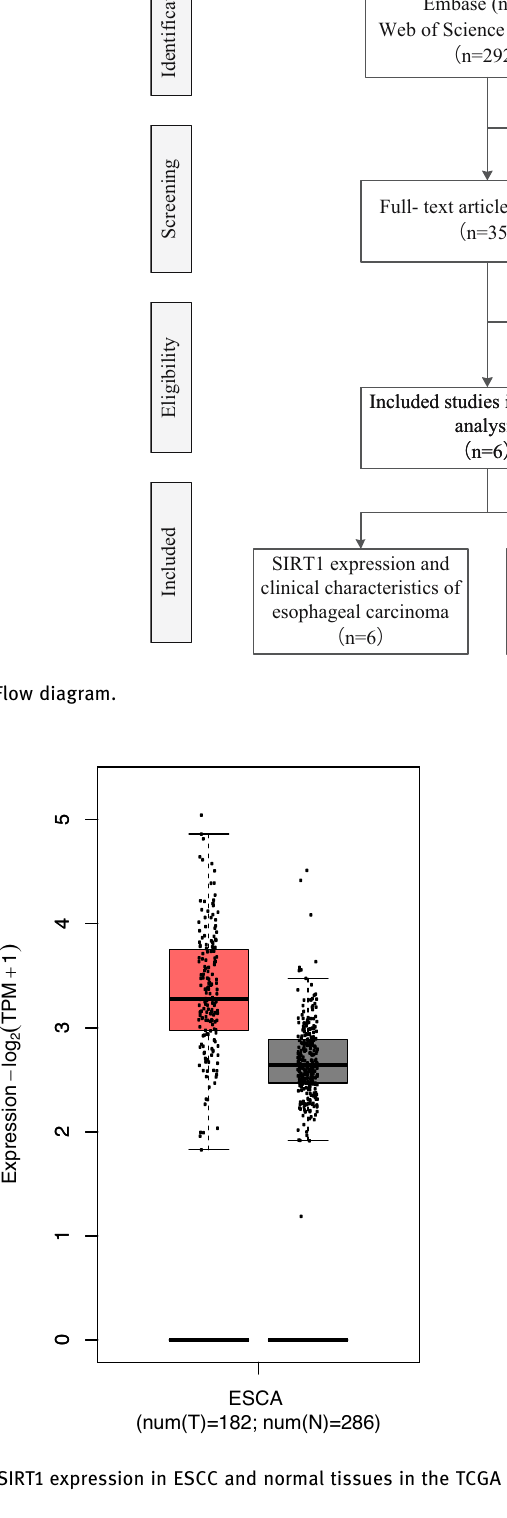
Figure 2: SIRT1 expression in ESCC and normal tissues in the TCGA